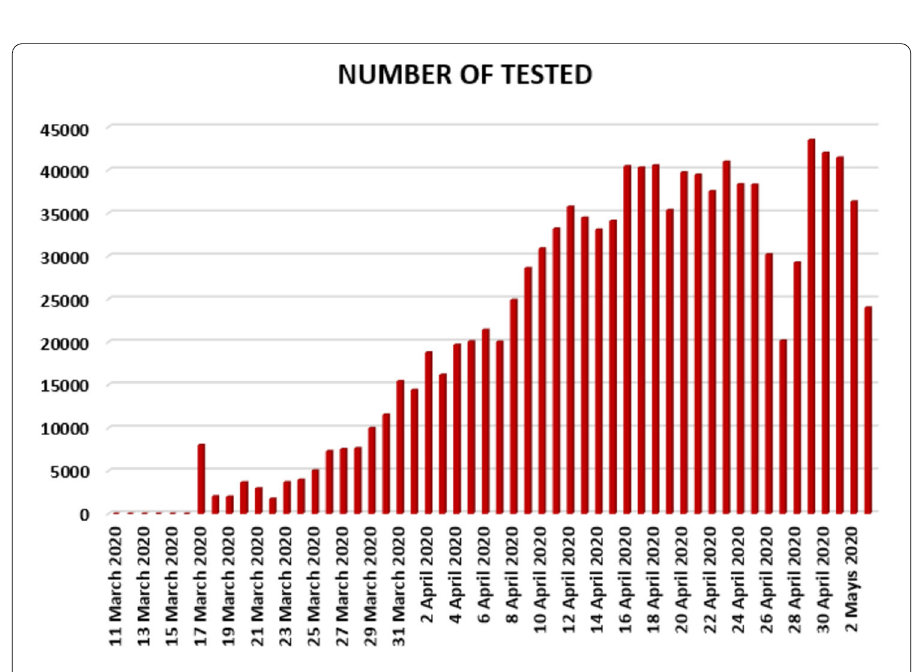
Figure 11 Number of tested people in Turkey from 11 March 2020 to 3 May 2020